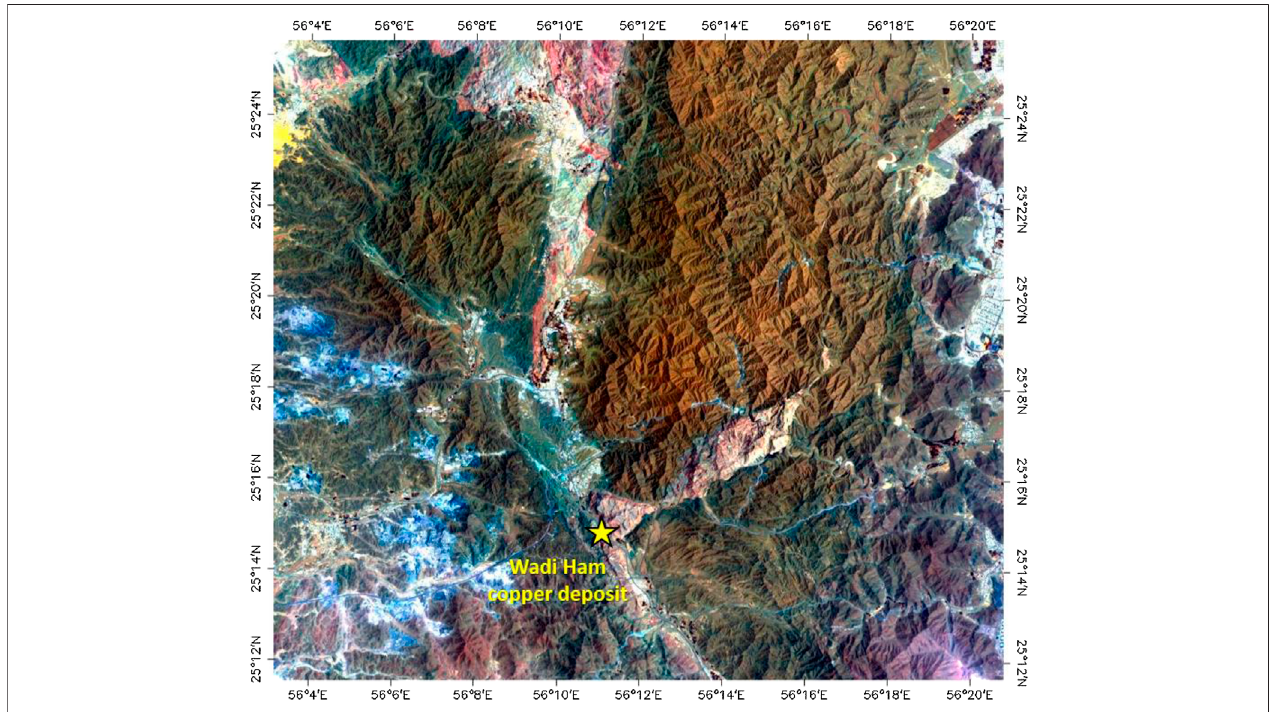
FIGURE 13 | Red – Green – Blue (RGB) (R: 7, G: 4, B: 2) composite image of the study area. The metamorphic sole is represented by the light pixels, where the dark pixels represent gabbro and peridotite rocks. The geographic reference for the location of the Wadi Hamm copper occurrence is 417,984 and